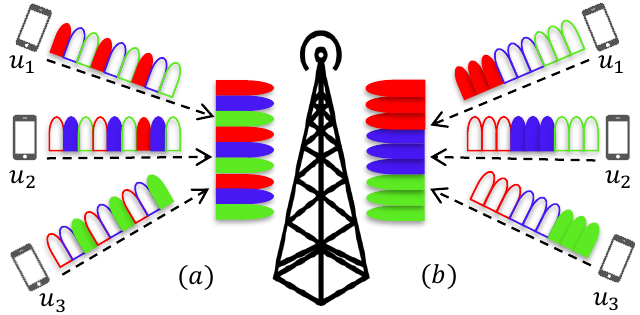
Figure 2. Uplink system model and user-subblock assignment methods: ( a ) interleaved; ( b ) localized. In frequency domain, each user’s band is shown with a different color. For a given user, filled bands represent used OFDM-IM subblock, which contains more than one